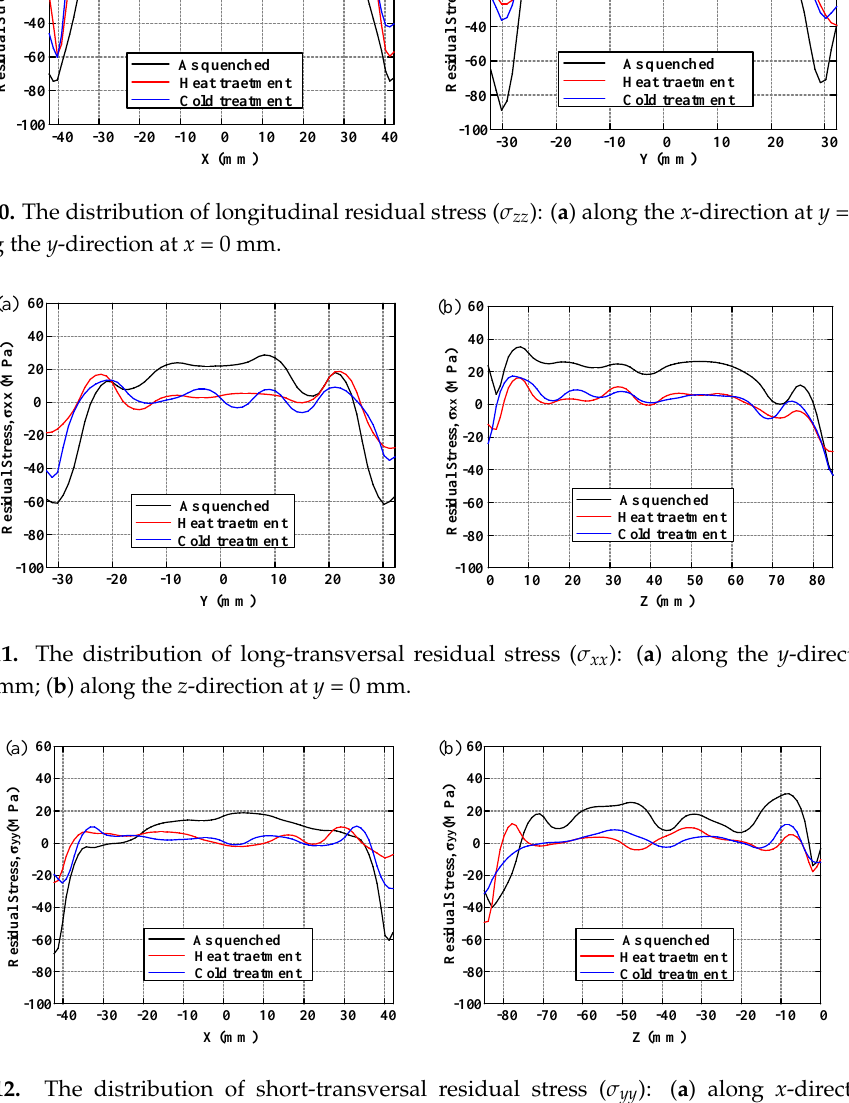
Figure 12. The distribution of short-transversal residual stress ( σ yy ): ( a ) along x -direction at z = −42.4 mm; ( b ) along z -direction at x = 0 mm.